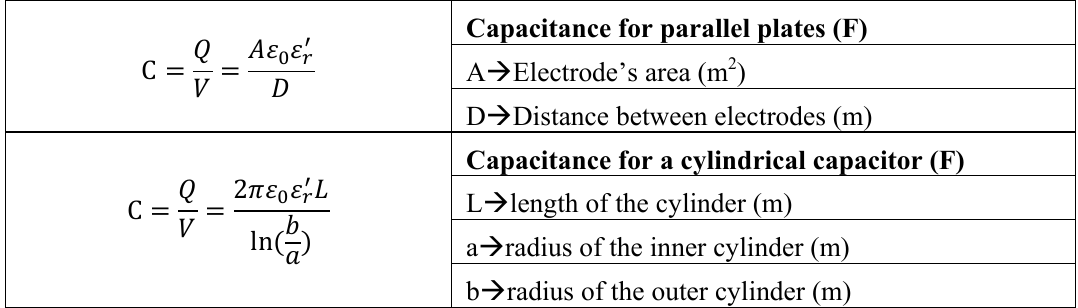
Table 1. Capacitance for different electrode